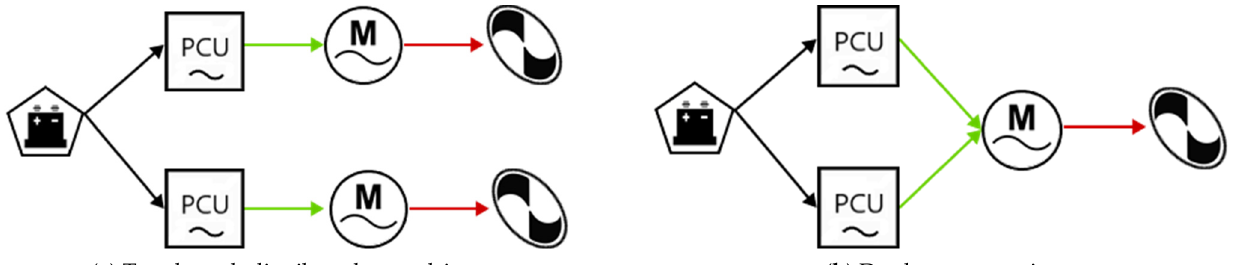
Figure 7. Examples of a parallel connection with equivalent branches.